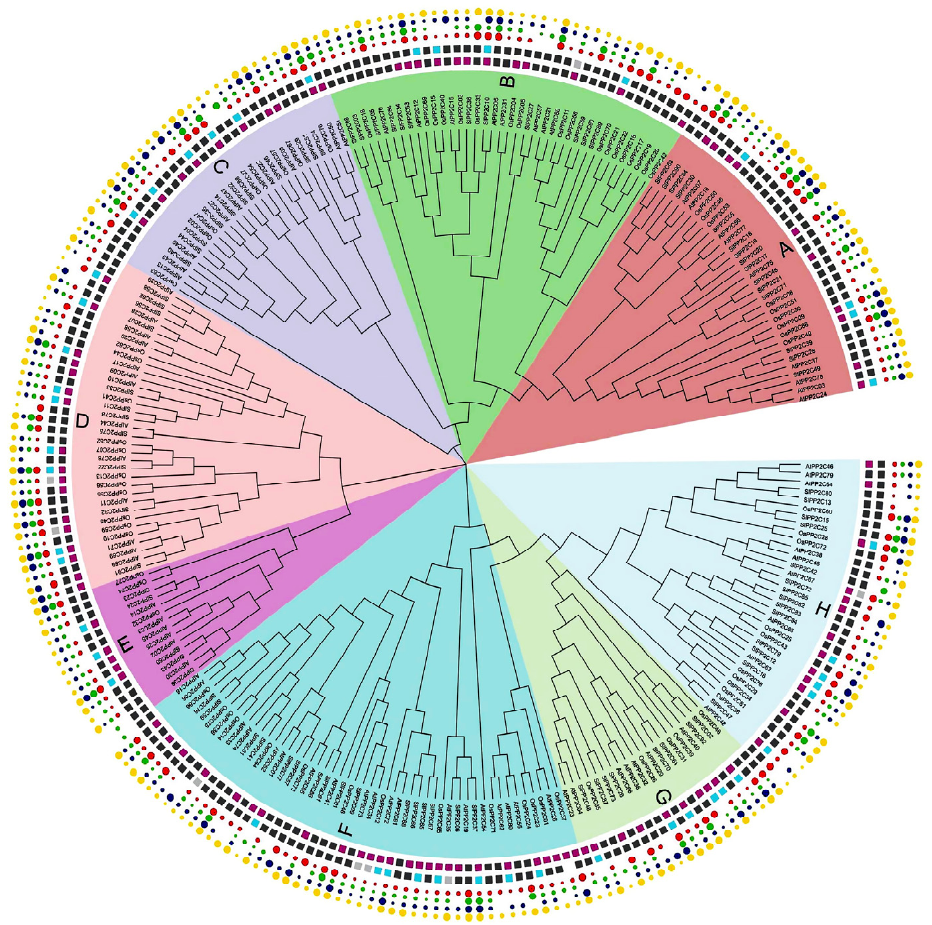
Figure 1. Phylogenetic analysis of the tomato PP2C family. It is based on protein sequence aligned by the ClustalW program. MEGA-X was used to construct a phylogenetic tree with the maximum likelihood method. Different colors indicate different subfamily members according to sequence similarity annotation analysis